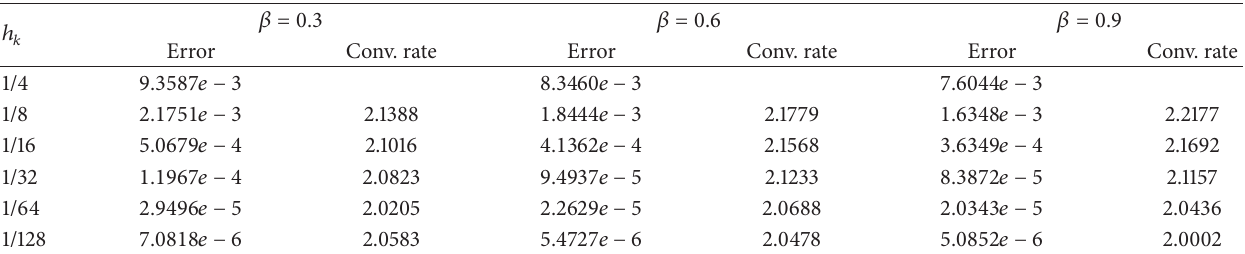
Table 1: Experimental error ‖ 𝑢 − ̂𝑢 𝑘 ‖ 𝐿 2 (Ω) for different 𝛽 .